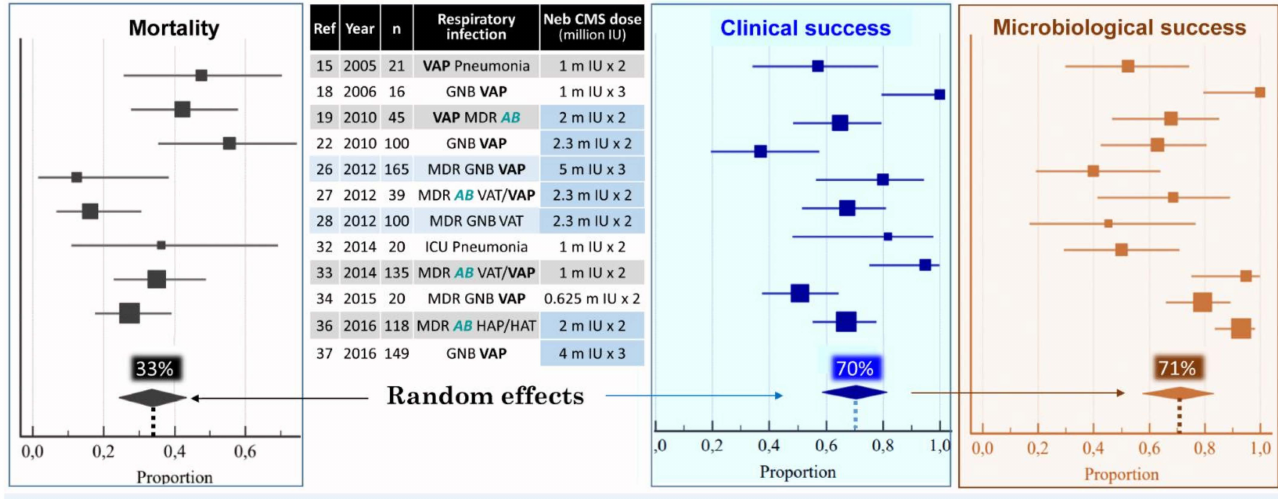
Figure 1. Pooled analysis of mortality, clinical and microbiological success among 908 patients treated with nebulized colistimethate sodium (CMS) for ventilator-associated pneumonia (VAP) or ventilator-associated tracheobronchitis (VAT) caused by multidrug-resistant (MDR) Gram-negative bacteria (GNB), particularly Acinetobacter baumannii (AB). Squares = proportion in each study; horizontal lines = 95% CI; diamonds = pooled proportion for the 12 studies. Doses of nebulized CMS are expressed in million international unit (IU). Adapted with permission from ref. [44]. Copyright 2017